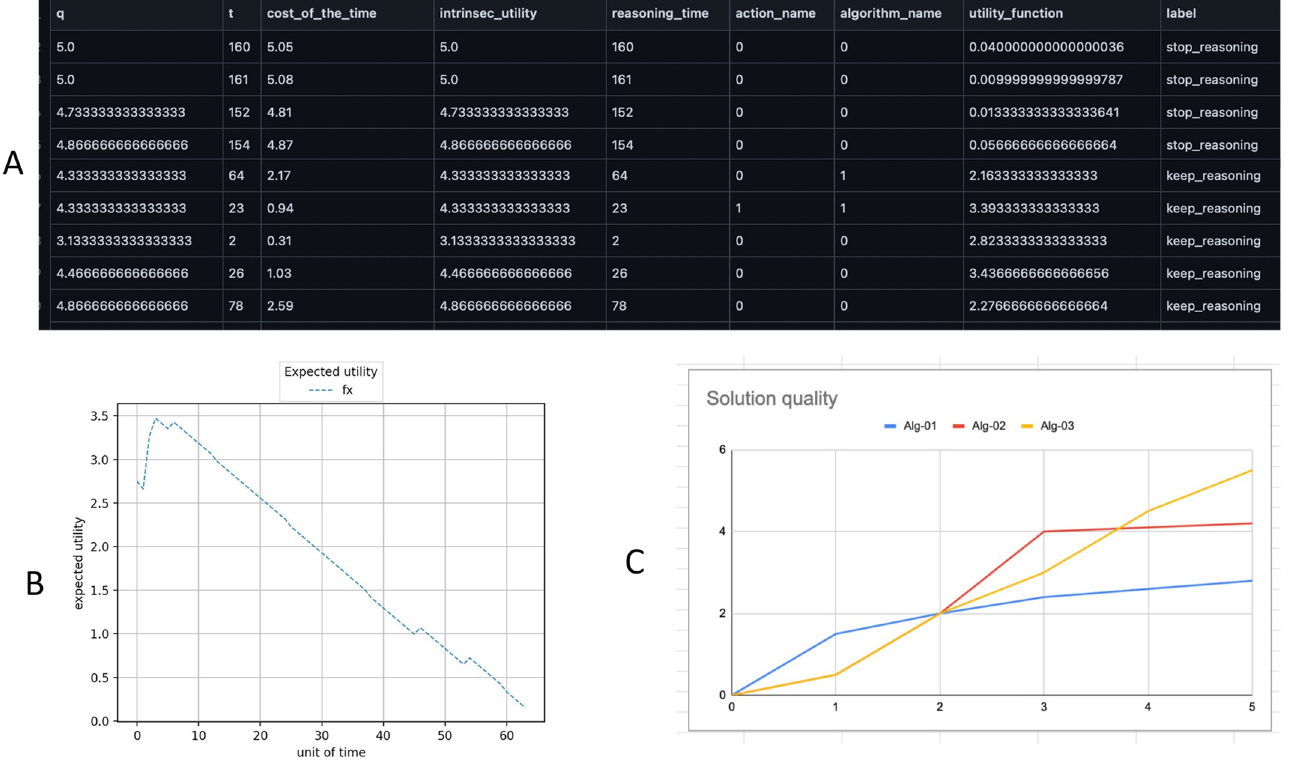
Figure 15. Data resulting from the validation process of TAIP. Section ( A ): dataset generated in a stopping reasoning problem. Section ( B ): behavior of the time-dependent utility function used to predict the stopping of the reasoning process. Section ( C ): performance profiles of three algorithms that solve TAIP, which ADTP uses to select a subset of algorithms according to the problem constraints. The x-axis represents reasoning loops.